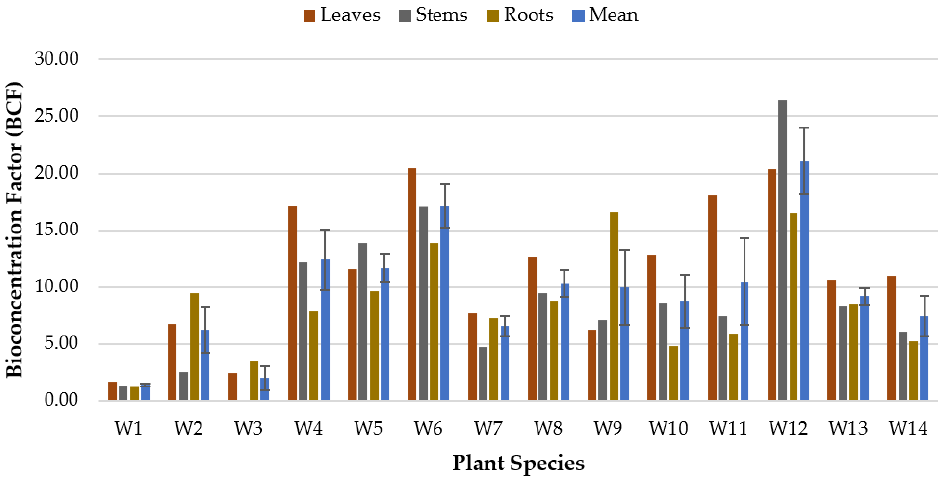
Figure 3. Bioconcentration factor (BCF) of calcium (Ca) in the phytoremediation of domestic sewage mesocosms using various tropical plants.